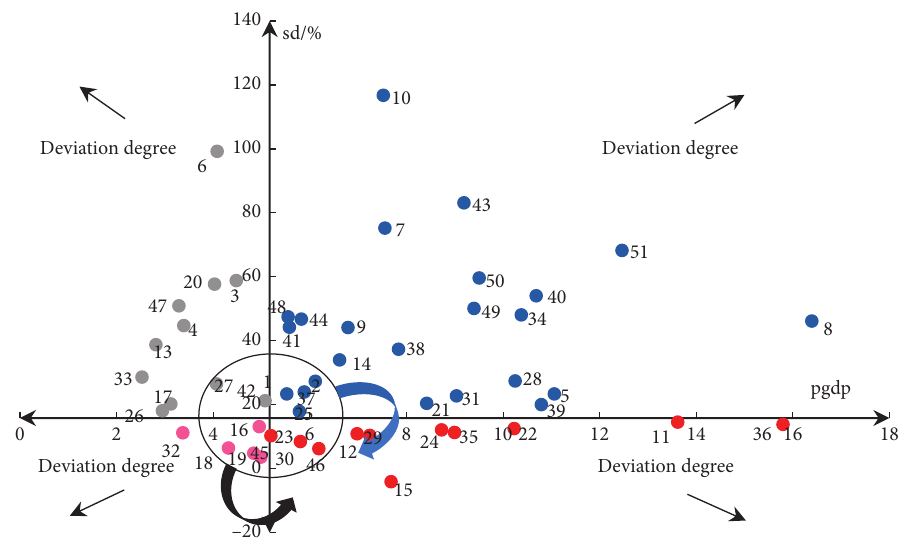
Figure 2: Quadrant distribution of different city types.